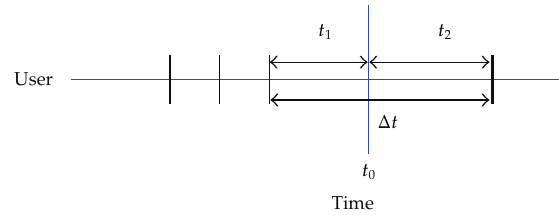
Figure 5: Comment patterns of user, each vertical line represents a separate comment on the news. The thick line denotes the time when the user comments on the news for the first time after it was released at t 0